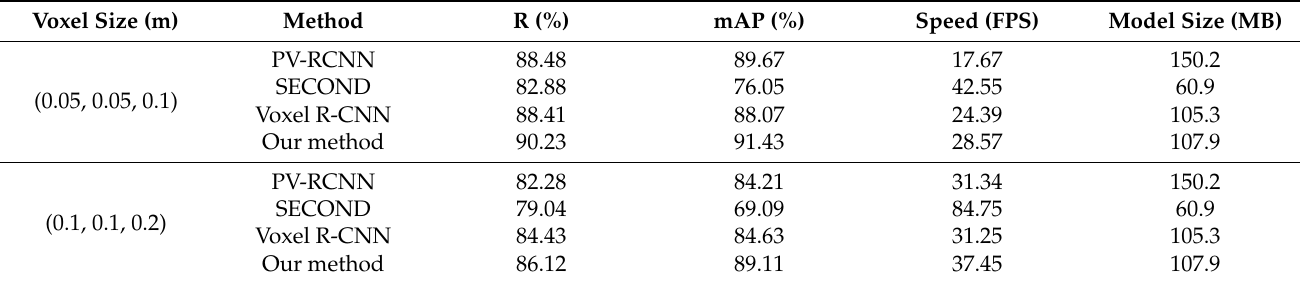
Table 3. Comparison of model detection results under different voxel sizes.